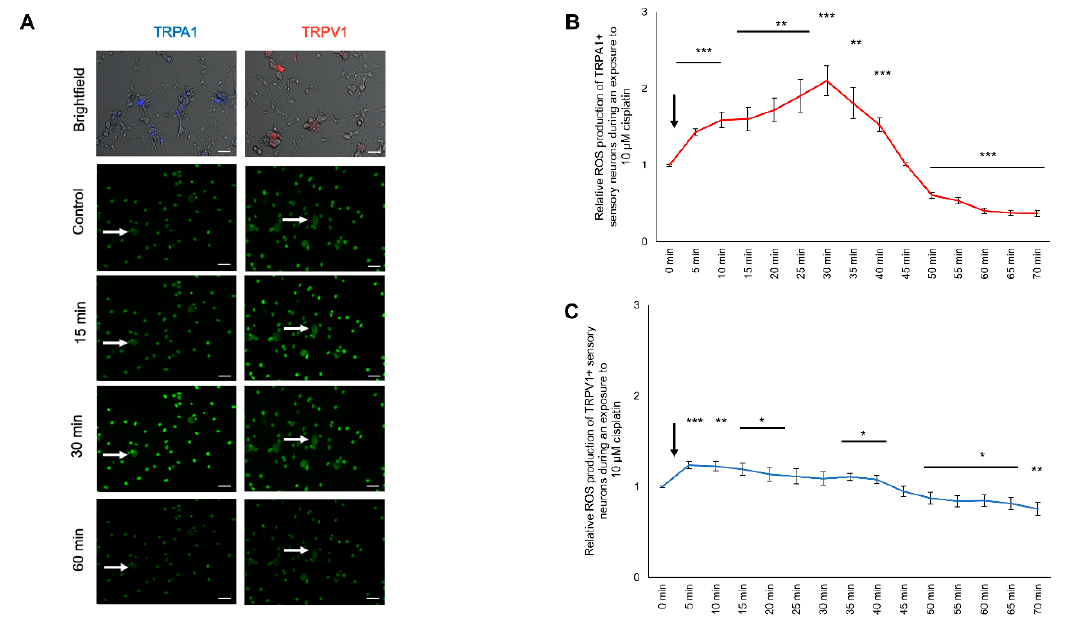
Figure 6. ROS production of TRPA1- or TRPV1-positive DRG neurons during exposure to 10 µM cisplatin. ( A ) Fluorescence of CellRox (green) in TRPA1- or TRPV1-positive DRG neurons during exposure to 10 µM cisplatin at different time points. ( B ) TRPA1-positive sensory neurons showed an instant increase of the ROS production to 1.431 ± 0.042 (*** p < 0.001) after 5 min and reached its peak at 2.100 ± 0.197 after 30 min (*** p < 0.001). After 50 min, the ROS production dropped below the control level at 50 min to 0.607 ± 0.036 (*** p < 0.001) and further declined to 0.370 ± 0.035 (*** p < 0.001) after 70 min. ( C ) After exposure to 10 µM cisplatin of the TRPV1-positive DRG neurons, the ROS production increased to 1.238 ± 0.042 (*** p < 0.001) after 5 min and dropped below control level at 50 min at 0.873 ± 0.068 (* p < 0.05) and steadily declined to 0.756 ± 0.072 (** p < 0.01) after 70 min. n = 6 cells per condition. * = significant effect compared to control level. Scale = 50 µm.